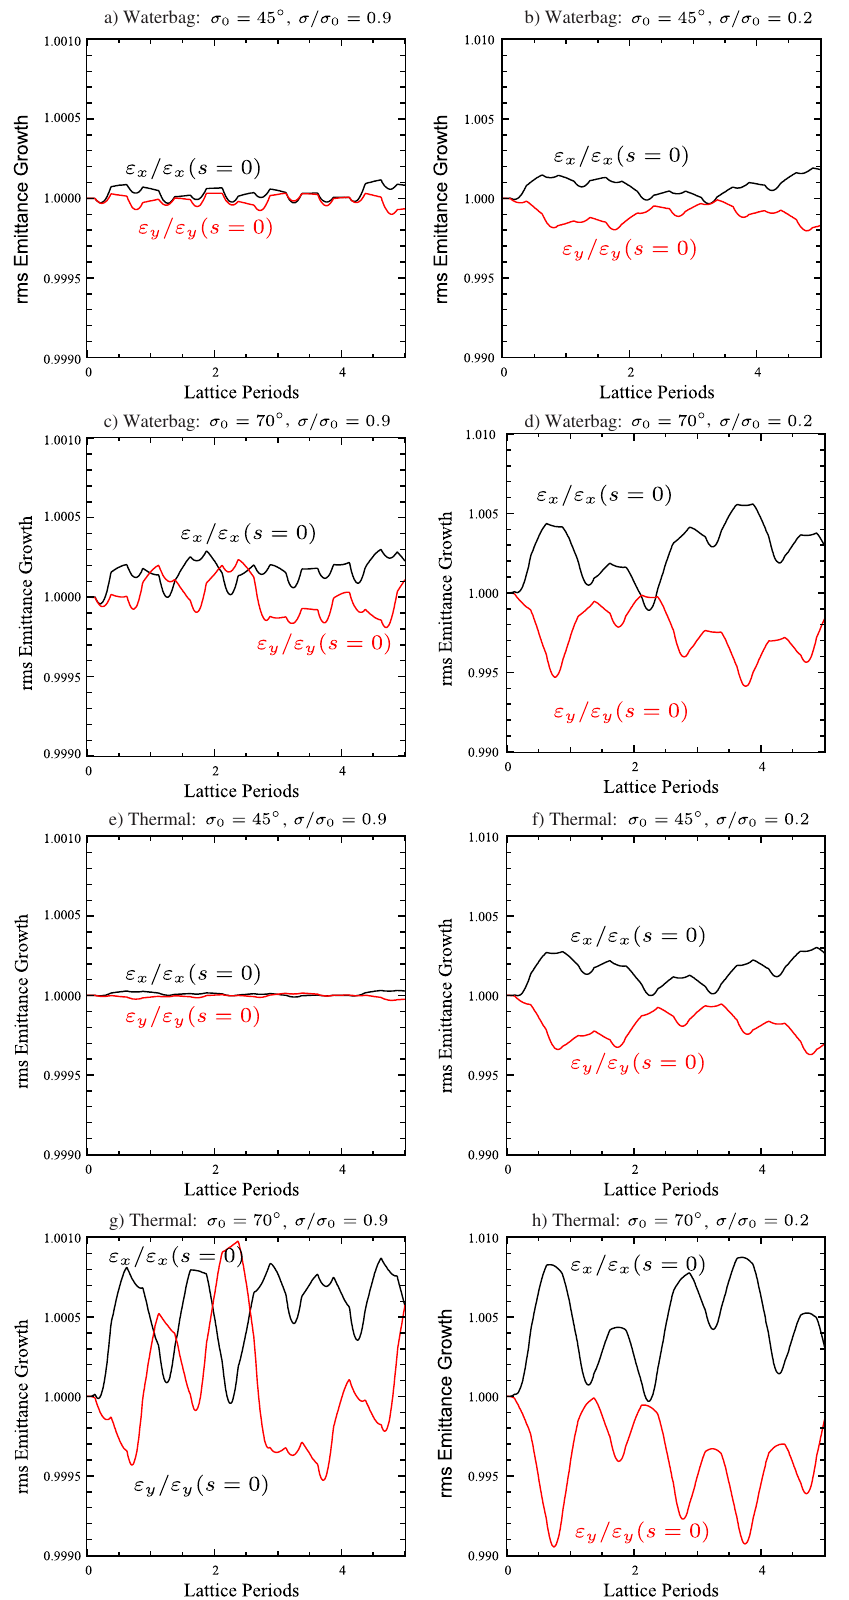
FIG. 7. (Color) Evolution of the beam rms-edge emittances " in Fig.